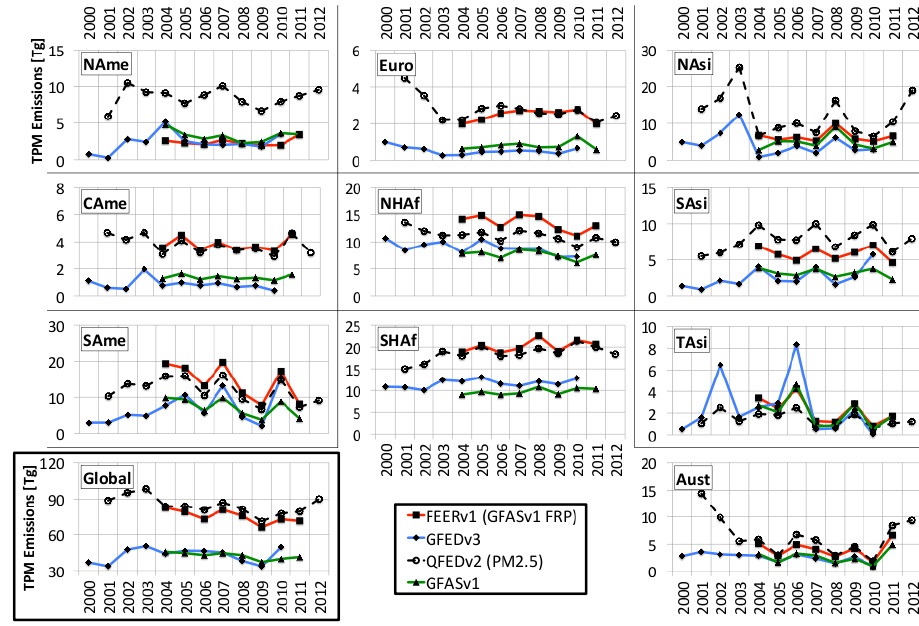
Figure 12. Time series of yearly total global and regional emissions of total particulate matter (TPM) in Tg from 2000–2012 for FEER.v1, GFED.v3, QFED.v2 and GFAS.v1, depending on data availability for this study. QFED.v2 values (dotted line) are for PM 2 . 5 . The regions represented are delimited on the map in Fig. 11.